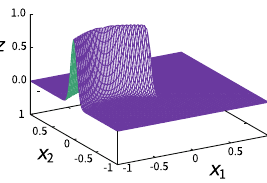
Fig. 2 A phase field variable z ( x , t ) approximating Σ( t